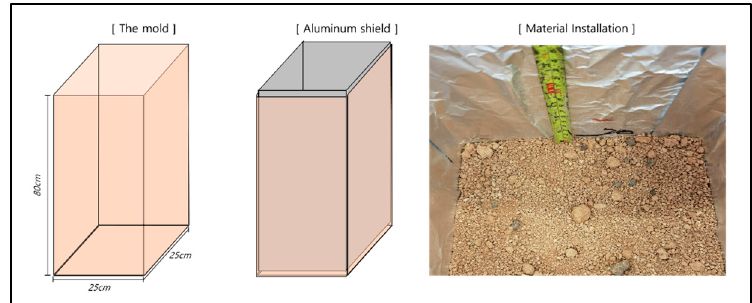
Figure 1. A scheme of experimental setup.